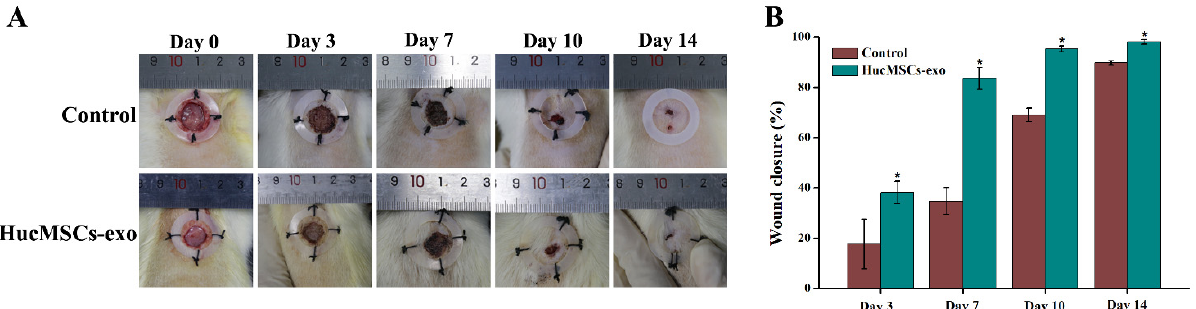
Figure 3. Diabetic wound healing induced by hucMSCs-exo in vivo. ( A ) Representative images of full-thickness dorsal wounds in STZ-induced diabetic rats at days 0, 3, 7, 10, and 14 post-wounding after treatment with phosphate-buffered saline (PBS as a control group) and hucMSCs-exo. ( B ) Quantification of wound closure at different time points in two groups (n = 5). * p < 0.05 shows a significant difference compared with the control group on the same day.